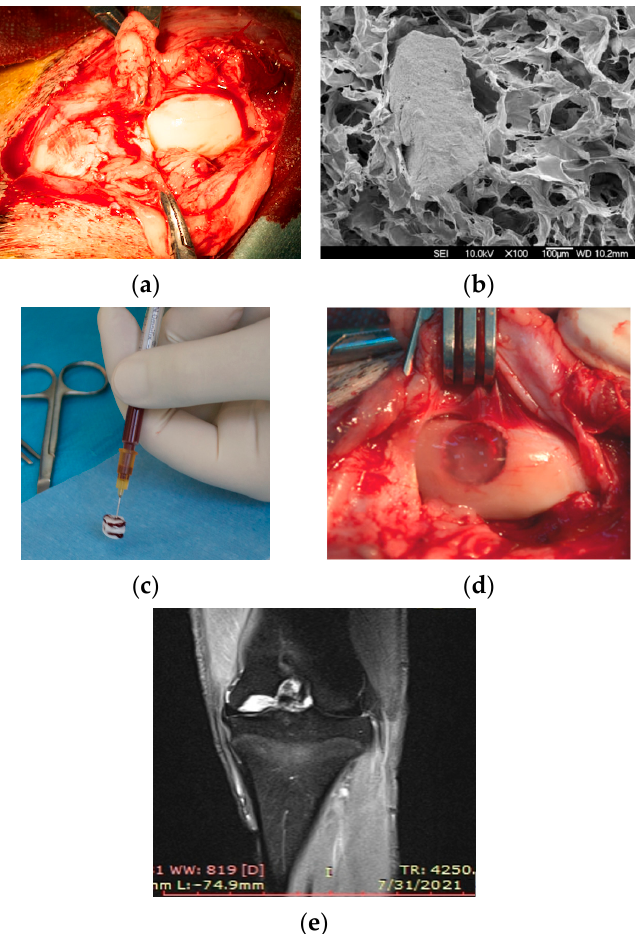
Figure 1. ( a ) Medial parapatellar approach over the left knee; ( b ) SEM image of porous collagen graft containing hydroxyapatite and tricalcium phosphate; ( c ) Injection of stem cells concentrate into the porous collagen implant; ( d ) Implant fixation in the defect using fibrin sealant; ( e ) MRI image after surgical intervention.